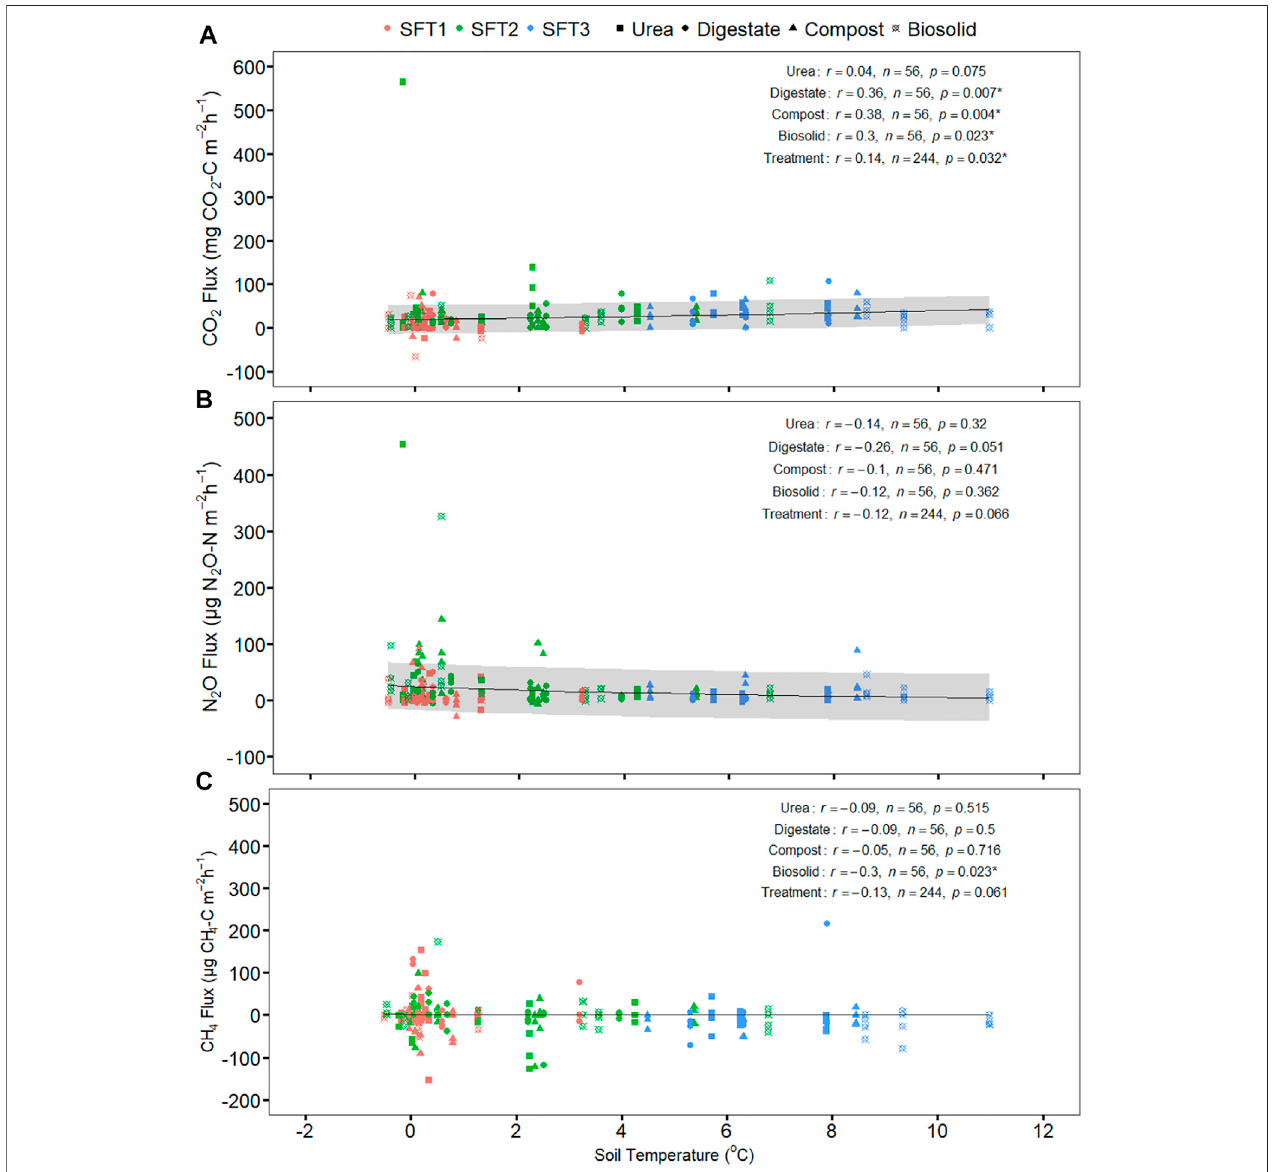
FIGURE 3 | The effect of soil temperature (~10 cm) on (A) CO 2 (B) N 2 O (C) CH 4 fl uxes release from the soil amended with urea and biobased residues during the spring freeze thaw event on 11 March to 24 March 2021. The graph presented the exponential model fi tted (solid gray line) and the standard deviation of an exponential model fi tted (gray shading) between greenhouse gas fl ux per treatment and soil temperature during the spring freeze thaw event (note: CH 4 fl ux standard deviation was not achieved due to iterative error caused by the many negative integers). The Pearson correlation coef fi cients ( r ) and the signi fi cant level ( p ) are shown for the treatments. SFT1 isthe fi rst spring freeze-thaw phase (waterlogged), SFT2 isthe second spring freeze-thaw phase (wet) and SFT3 is the third spring freeze-thawphase (dry). * Shows p -value <